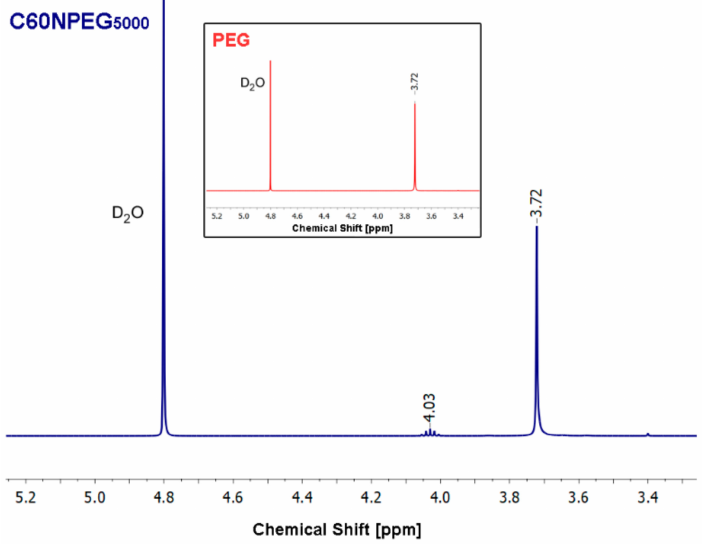
Figure 2. 1 H NMR spectrum of PEG-functionalized C 60 fullerene and pure PEG (insert). The registered FTIR spectrum showed broad signal centered at 3396 cm − 1 , which can be attributed to O-H stretching of terminal hydroxyl groups (Figure 3). The alkane C-H stretching signals were observed at 3967, 2927, and 2861 cm − 1 . Next signal, which was registered at 1670 cm − 1 can be related to C=C stretching band or hydroxyl groups [26], and was reported previously in other PEG-functionalized fullerene derivatives [25]. Peak observed at 1387 cm − 1 was associated with O-H bending mode. The C-O-C stretching band coming from PEG chain was registered at 1255 cm − 1 , along with typical ether C-O stretching vibration observed at 1094 cm − 1 . As expected, for C 60 fullerene core sharp signals at 576 and 527 cm − 1 were presented in the fingerprint region of the registered spectrum [27].